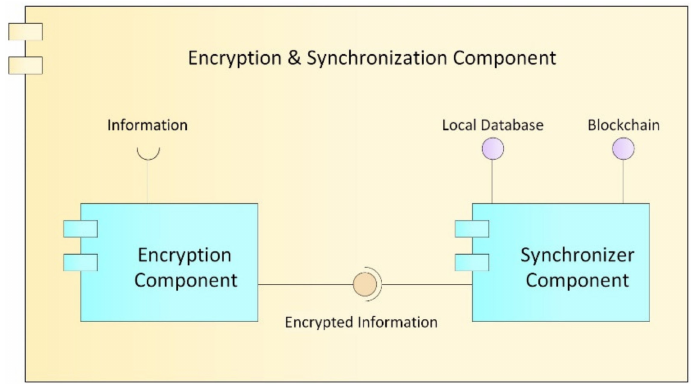
Figure 8. Encryption and synchronization